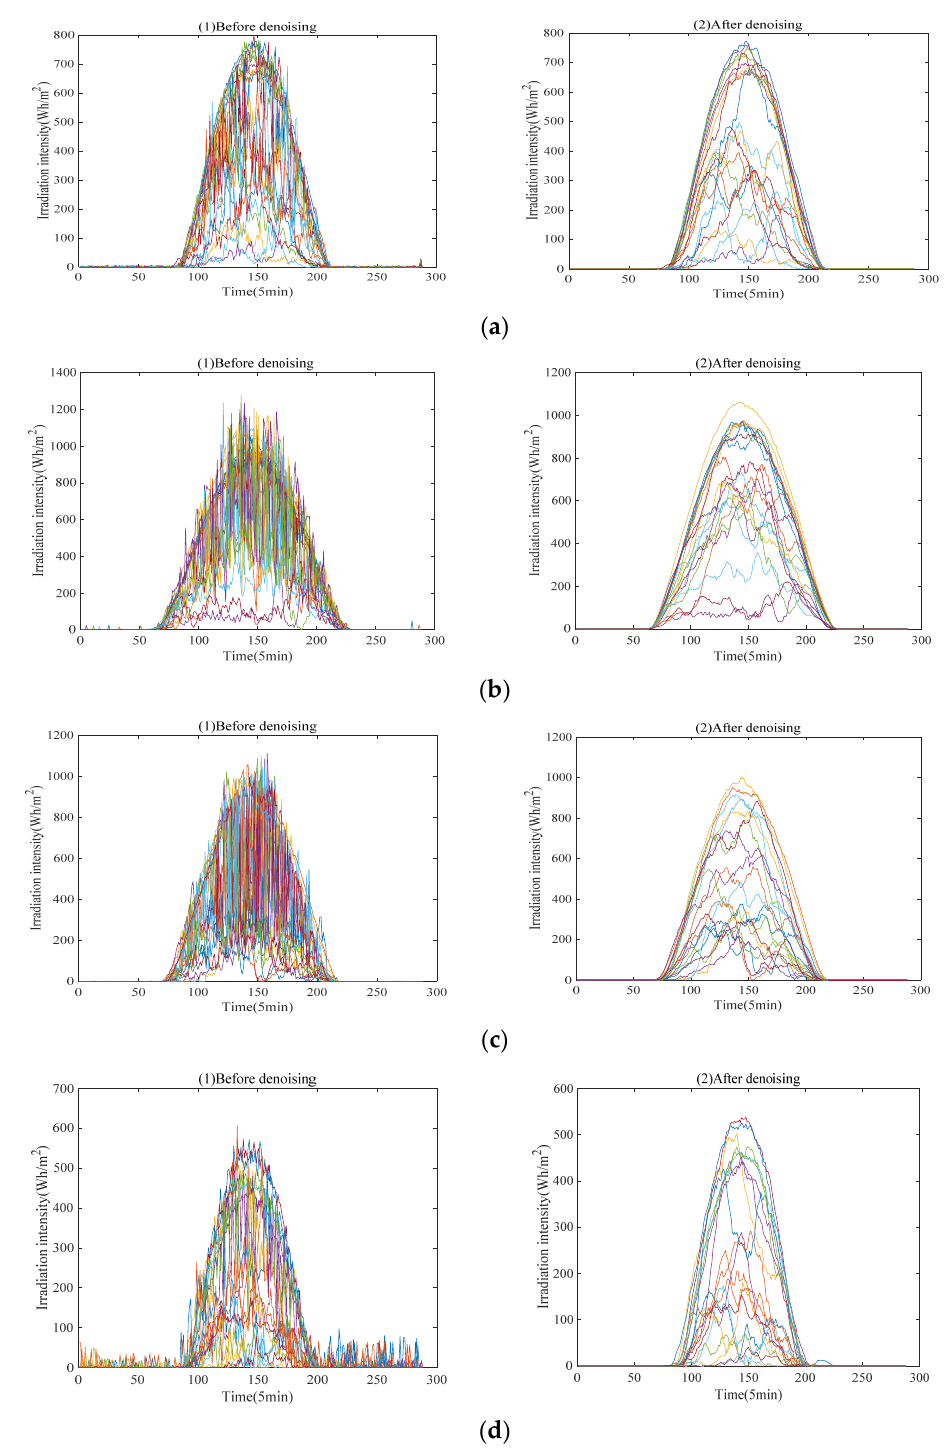
Figure 10. Solar radiation waveform before and after denoising in four seasons. ( a ) Spring; ( b ) Summer; ( c ) Autumn; ( d ) Winter.